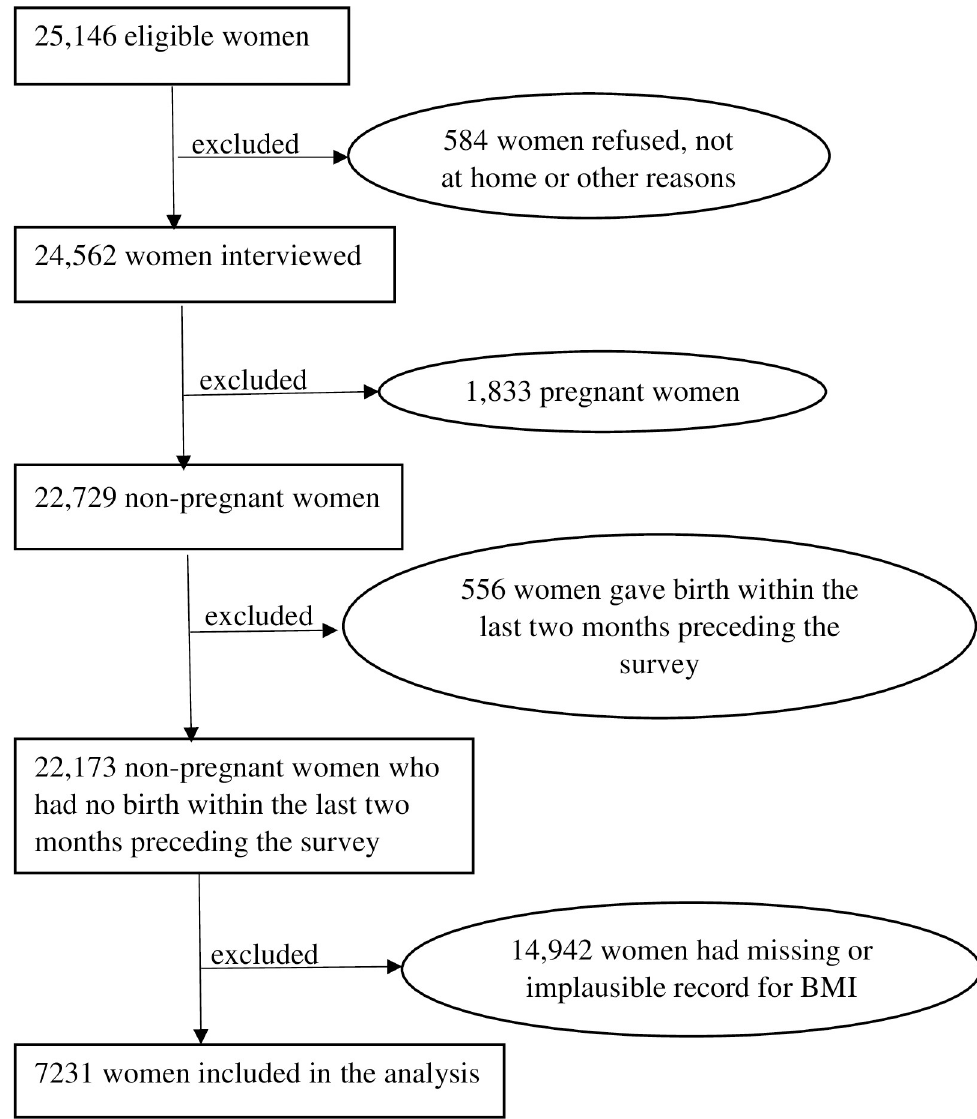
Fig 1. Flowchart depicting the study population’s selection